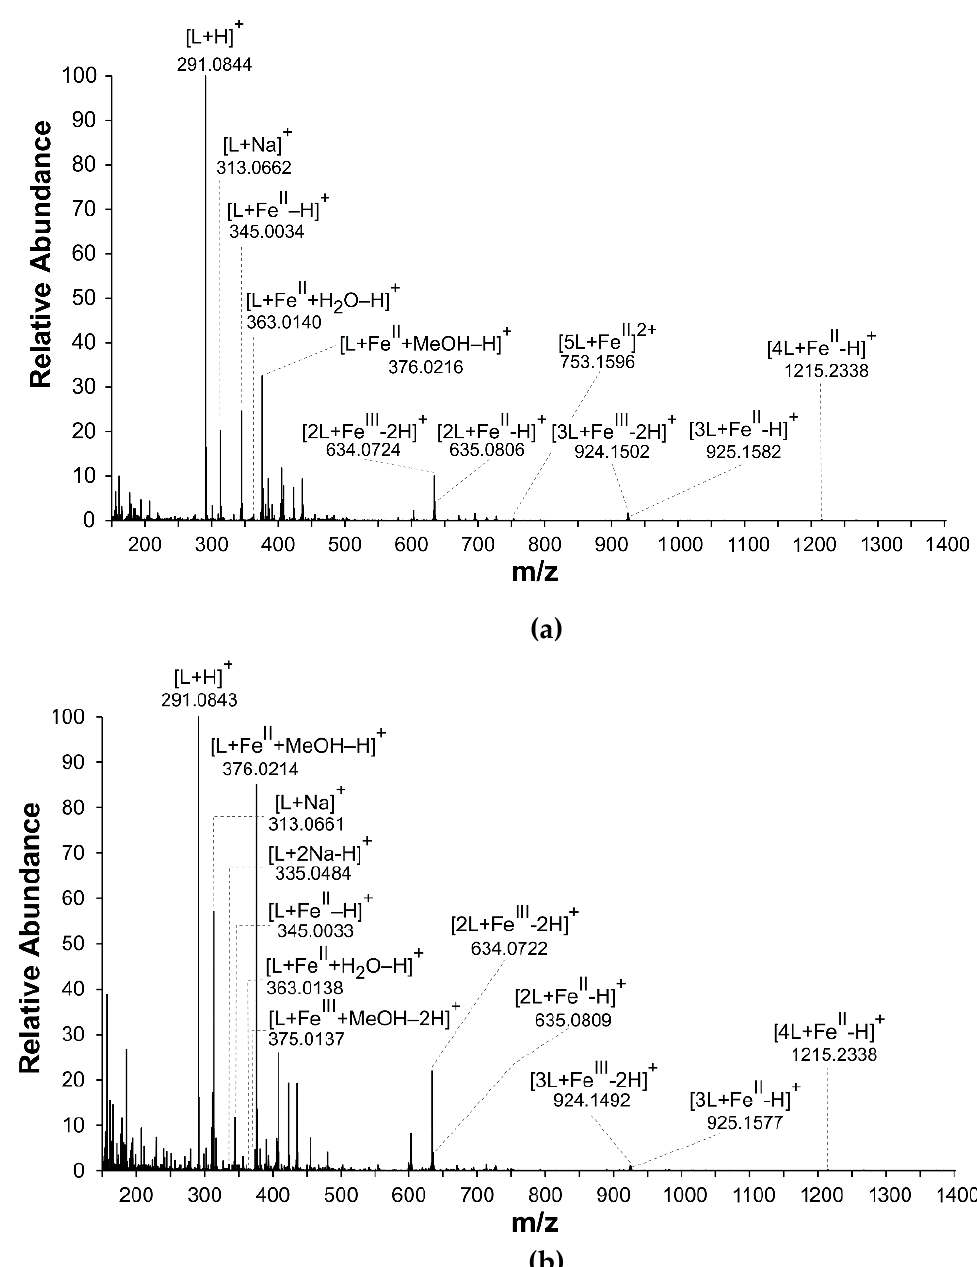
Figure 2. Mass spectra of coordination complexes in solutions of ( ± )-catechin (L) with ( a ) Fe II and ( b ) Fe III , detected by nano-ESI–MS, positive ionization mode. The solutions were prepared by mixing a ( ± )-catechin solution with Fe II or Fe III solutions in a molar metal-to-ligand ratio of